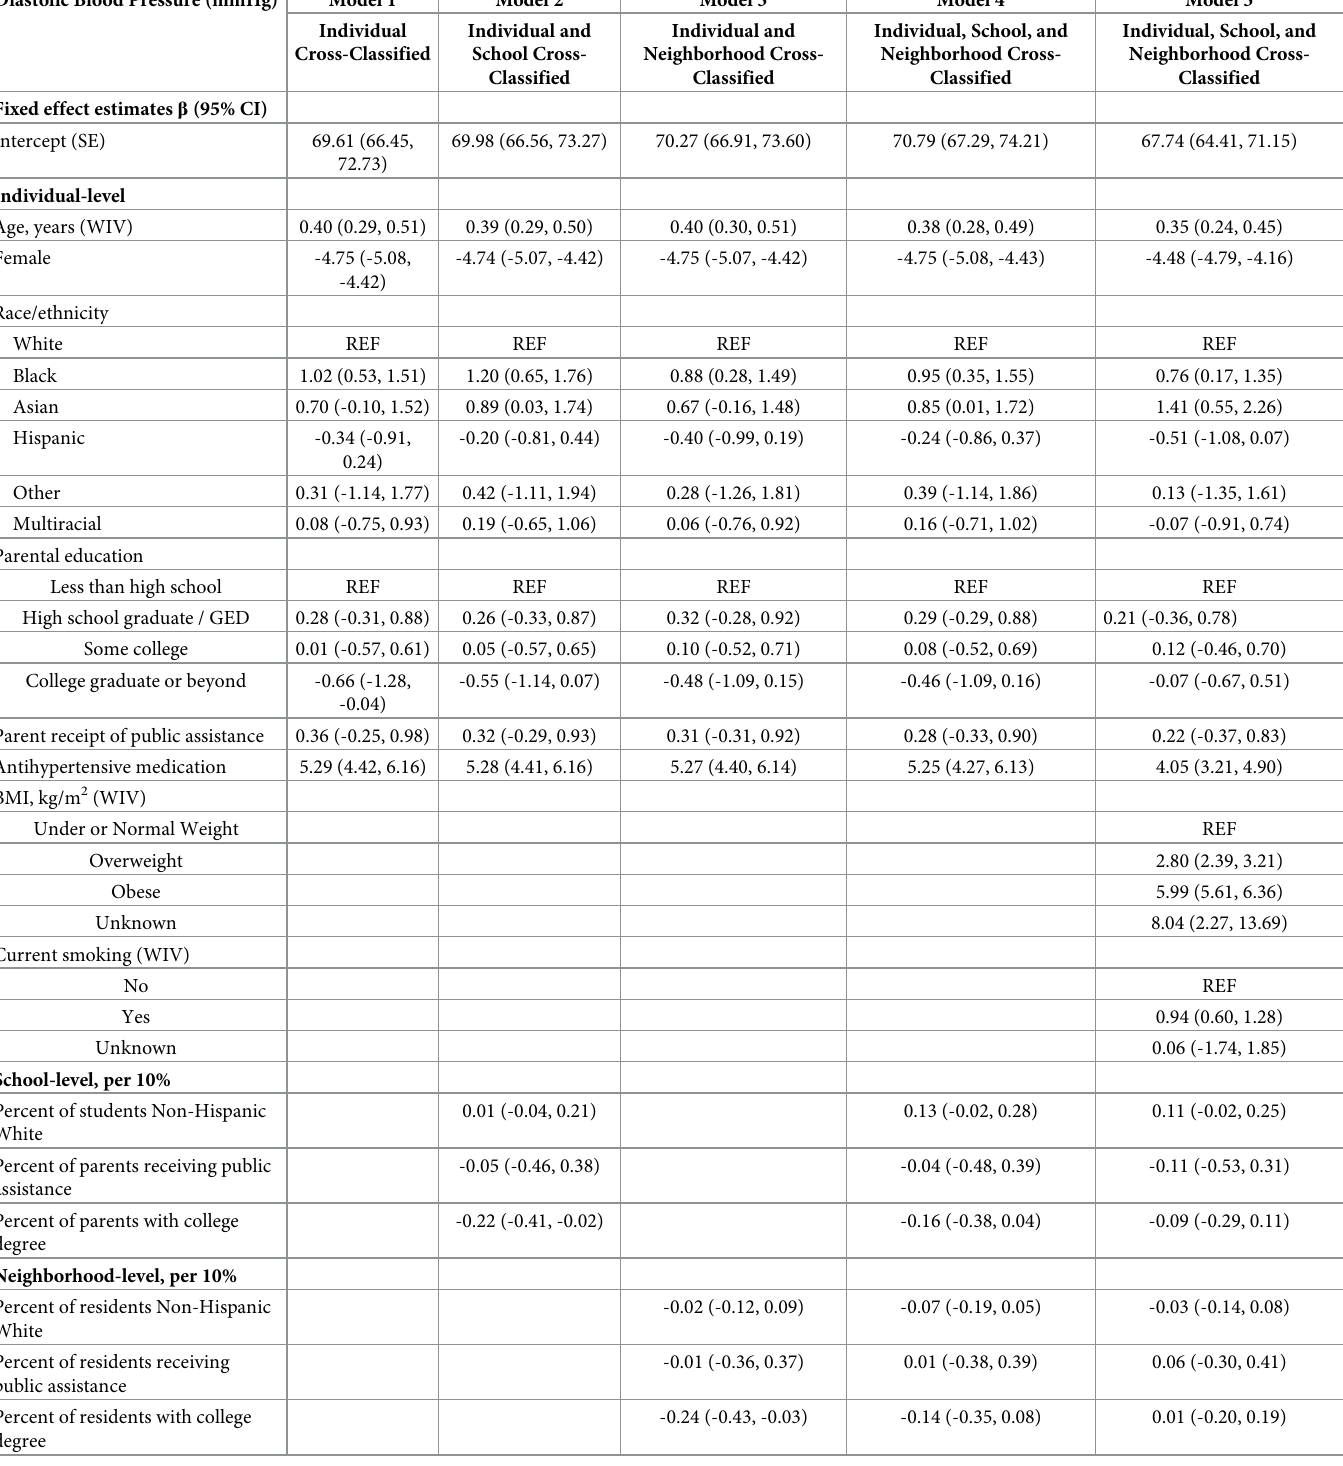
Table 4. Linear cross-classified multilevel models (CCMM) predicting diastolic blood pressure from individual-, school- and neighborhood-level factors in the National Longitudinal Study of Adolescent to Adult Health, Wave IV (WIV), 2008–2009 (N =